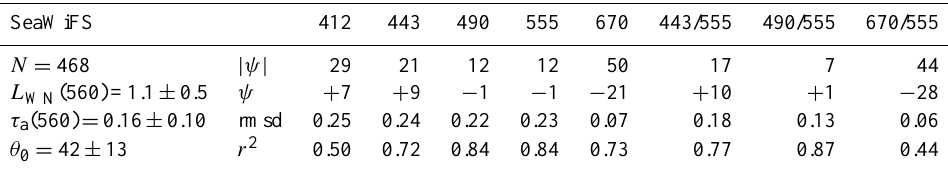
Table 8. Statistical results from the analysis of MODIS-A and AERONET-OC L WN , and their ratios at specific center wavelengths for the N available match-ups determined at the AAOT with 1t =± 1h. Symbols and units are the same as in Table 1. MODIS-A 413 L WN (547) = 1.1 ± 0.6 τ a (560) = 0.15 ±